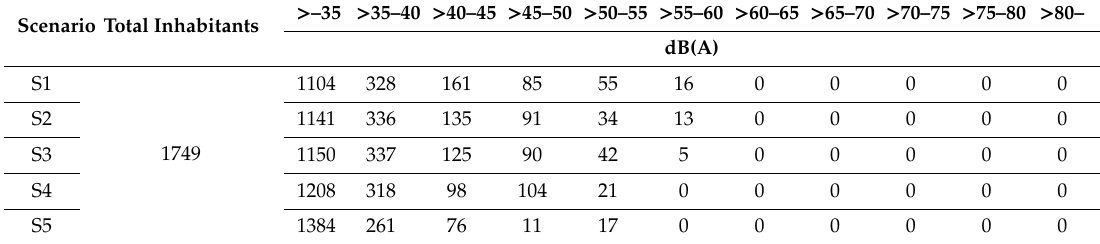
Table 1. Inhabitants’ noise exposure in the day period.